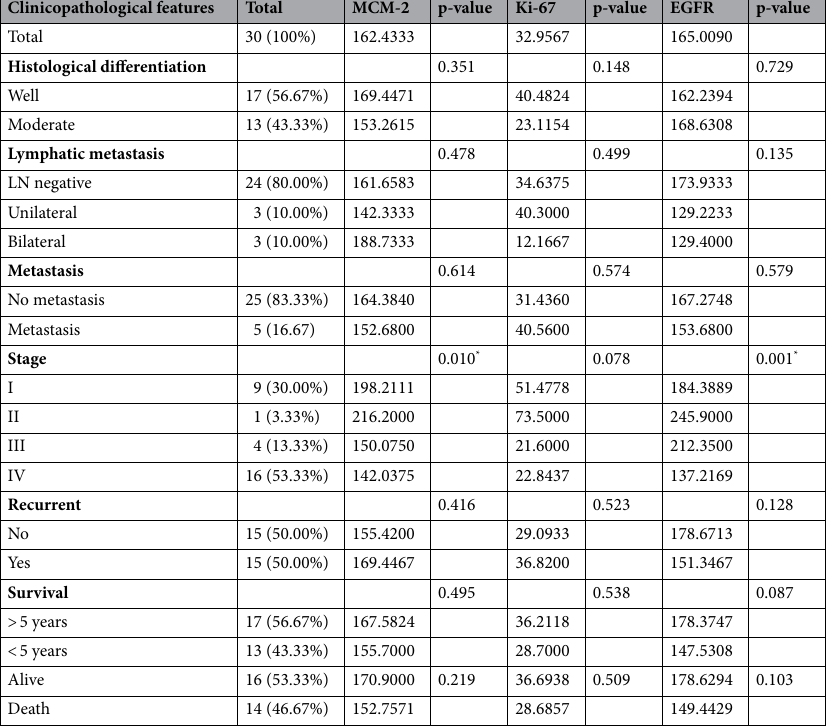
Table 1. Clinicopathological features of a total 30 LSCC patients. * Differences were statistically